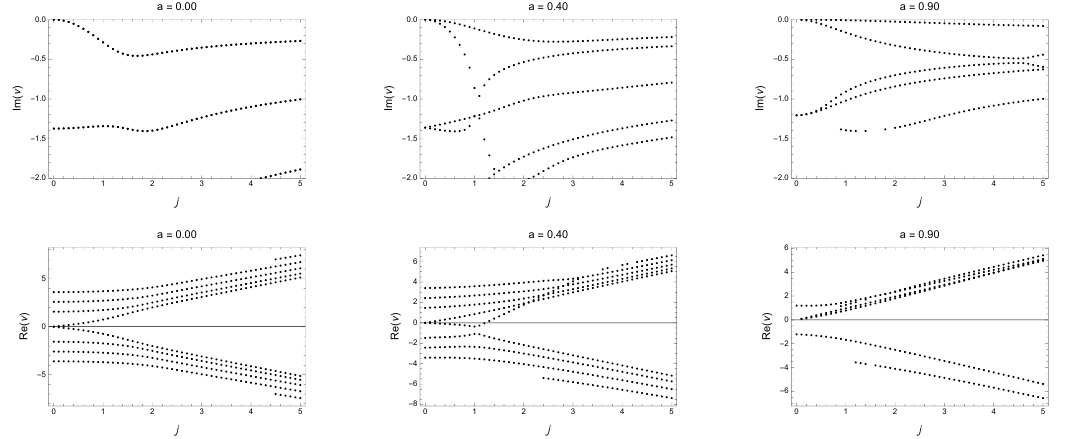
Figure 7 . Scalar QNMs of the simply spinning black hole. There are two hydrodynamic modes, which we identify as sounds modes, which mirror each other regarding their real part at a = 0, and both have the same imaginary part. At a = 0 these two modes behave di(cid:11)erently. Modes displayed here were found with precision of at least d(cid:23) = (cid:23) 10 (cid:0) 5 . Missing modes did not converge to su(cid:14)cient precision and have been (cid:12)ltered out by the numerical